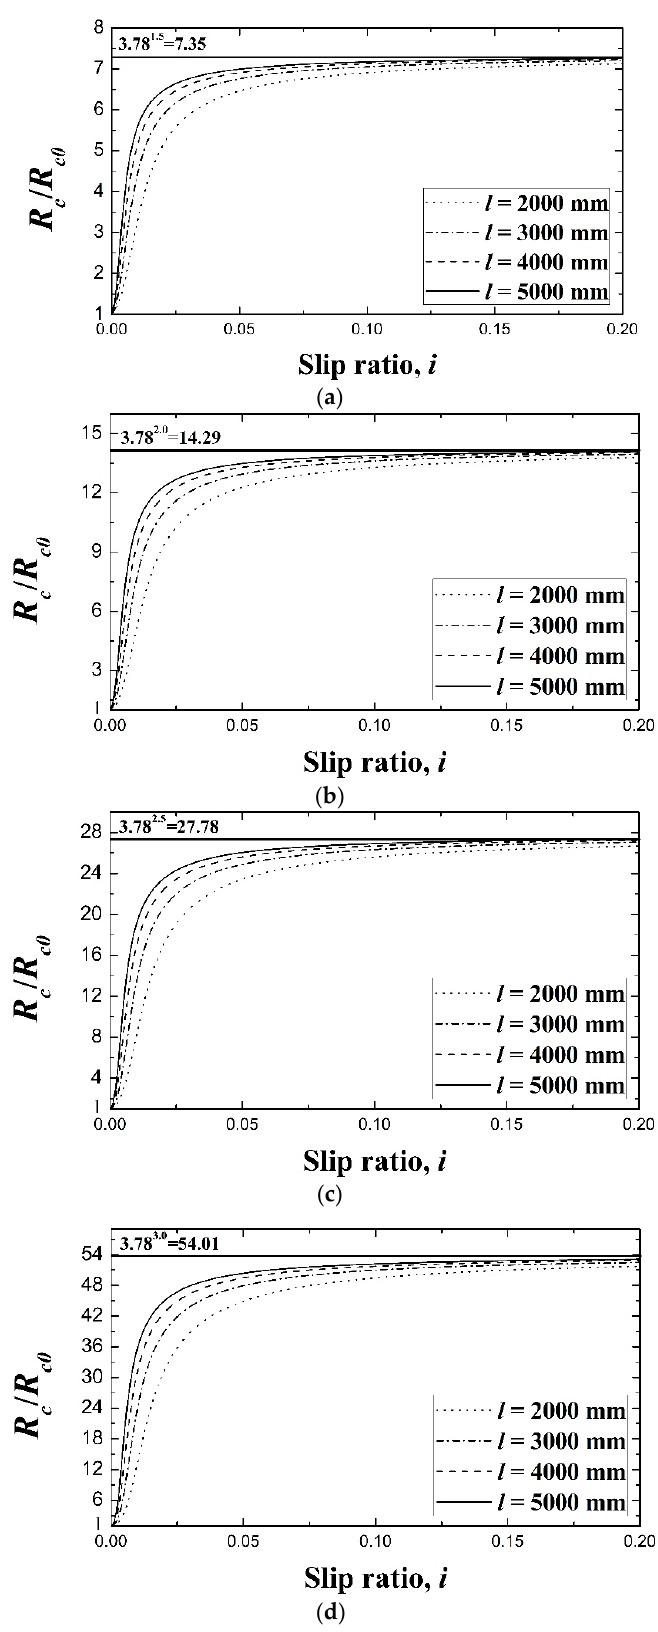
Figure 14. Normalized compaction resistance considering slip sinkage R c / R c0 : ( a ) n = 0.5, ( b ) n = 1.0, ( c ) n = 1.5, and ( d ) n = 2.0.